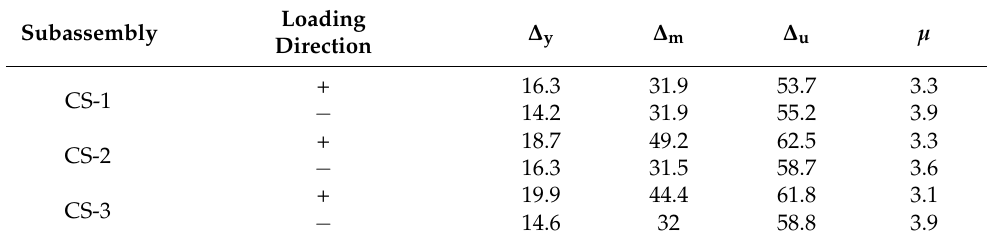
Table 5. Measured top lateral drift of subassemblies (unit: mm).